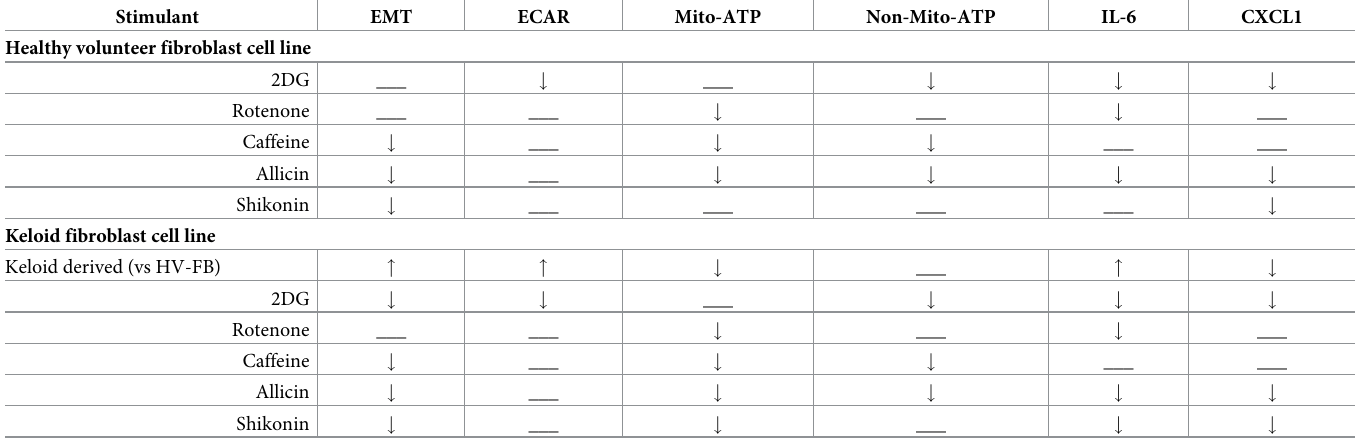
Table 2. Summary of impacts of compounds on healthy volunteer and keloid fibroblasts. Summary of impacts of the glycolysis inhibitor (2DG), the mitochondrial ATP inhibitor (rotenone), caffeine, allicin, and shikonin on scratch assay healing time, extracellular acidification rate (ECAR), mitochondrial ATP production